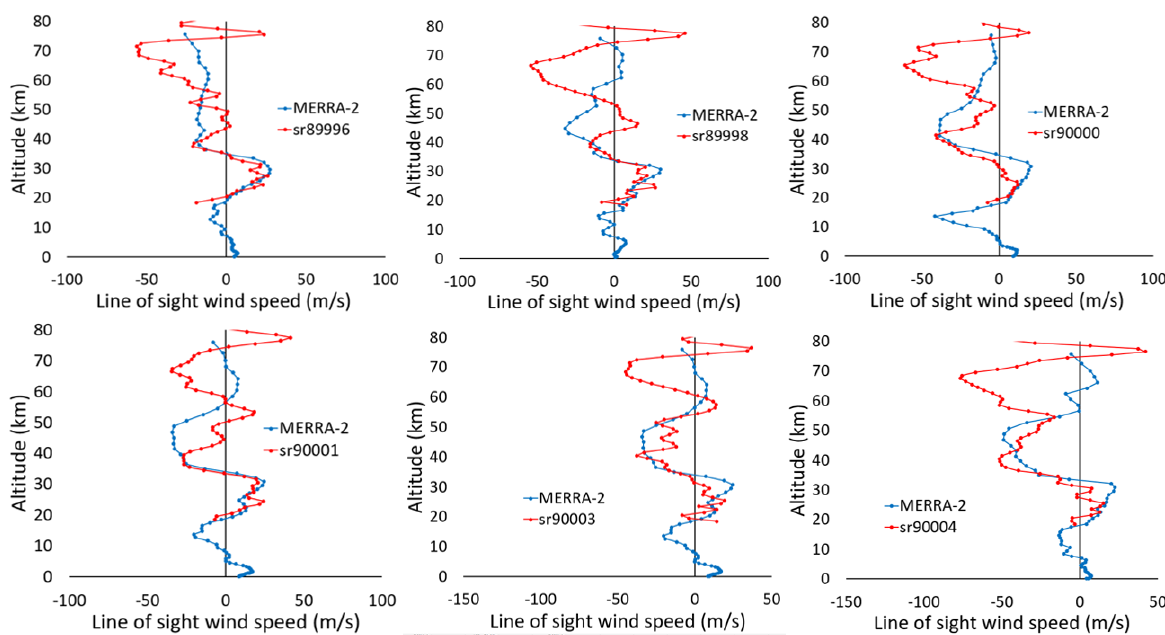
Figure 8. Comparisons of MERRA-2 results to a set of tropical ACE-FTS sunrise occultations on 26 April 2020.